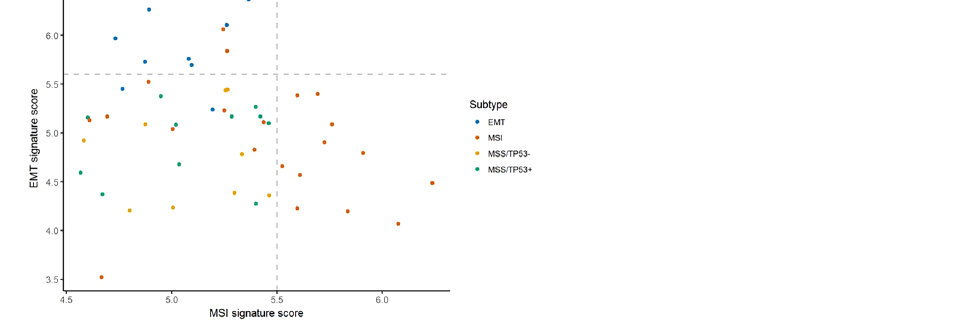
Figure 3. Score distribution of EMT and MSI signatures to assign mesenchyme and MSI subtypes,